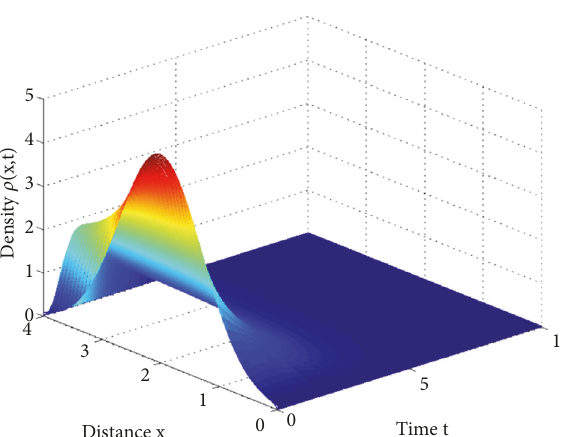
Figure 2: Finite-time control of the crowd evacuation system.